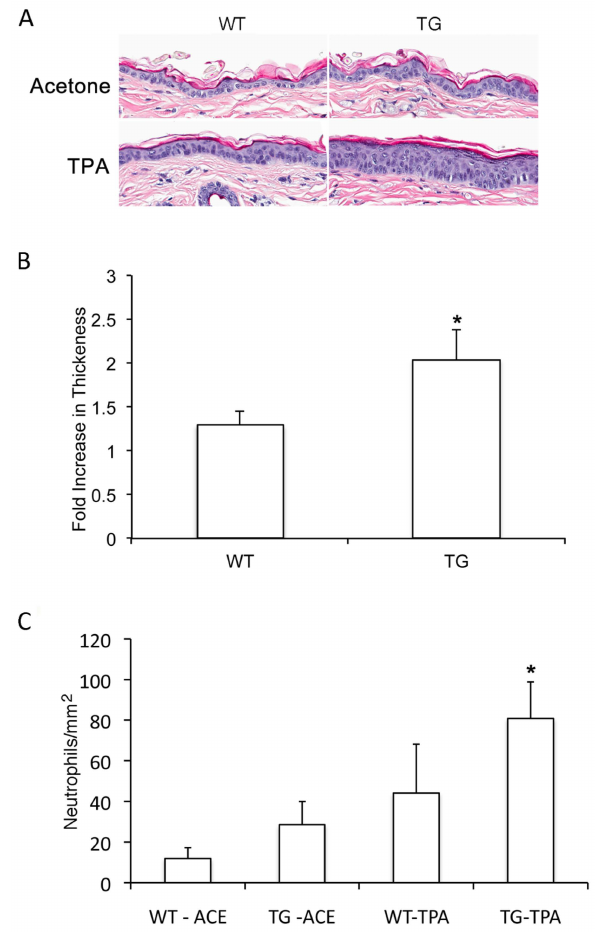
Figure 3. Slug modulates TPA-induced epidermal hyperplasia and acute cutaneous inflammation. Slug transgenic and wild-type mice were treated once with TPA, and skin was collected 24 h later. ( A ) H & E-staining showed enhanced hyperplasia in transgenic compared to wild-type epidermis treated with TPA. ( B ) Quantification of hyperplasia by morphometry showed a significant difference between the degree of hyperplasia in transgenic versus wild-type skin. Hyperplasia is shown as a fold increase in epidermal thickness compared to acetone-treated skin. Results were compared by the Mann–Whitney test. * One-tailed p -value significantly different from wild-type epidermis. Bars indicate SD. ( C ) Quantification of neutrophil number in skin was performed by staining for Ly6G followed by morphometry. Results were compared by the Mann–Whitney test. * One-tailed p -value